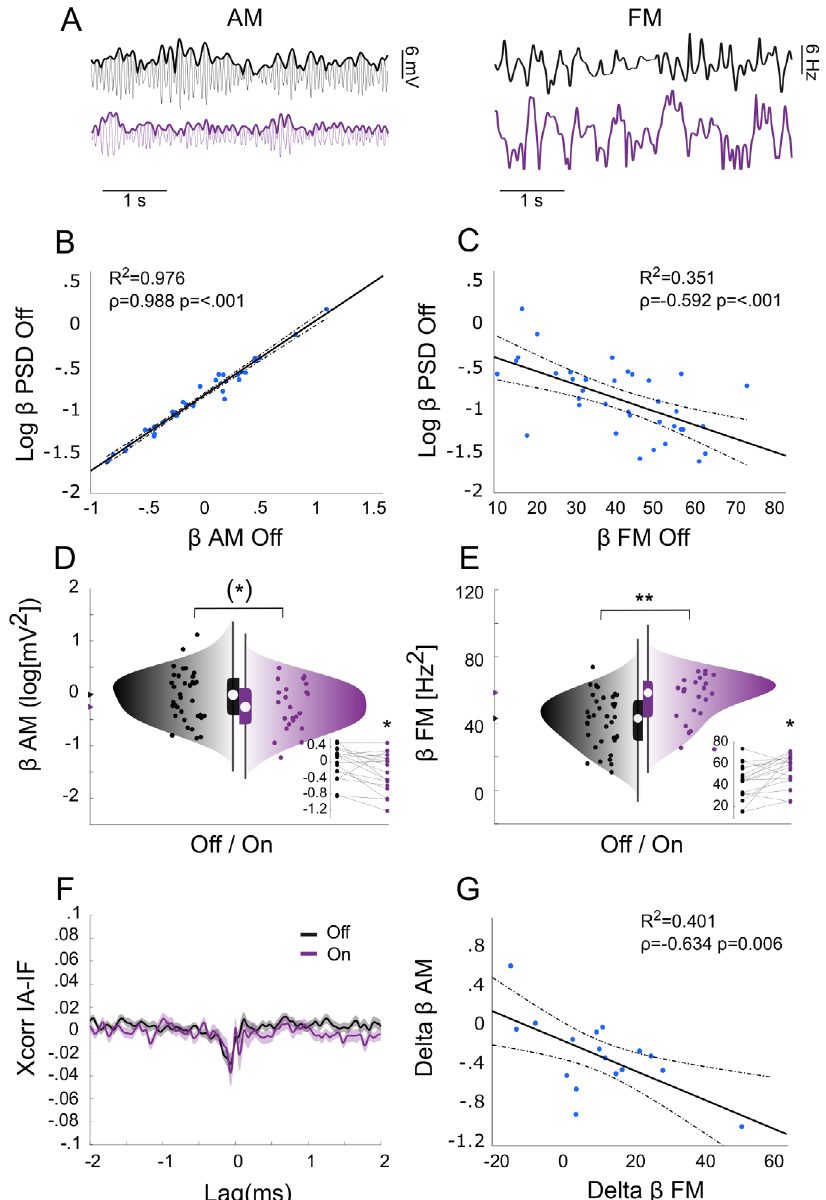
Fig. 2 Dopamine-dependent AM and FM of STN beta oscillations in PD patients. A Representative signals of instantaneous amplitude (left) and instantaneous frequency (right) before (black) and after (violet) levodopa. B , C Scatter plots of logarithmic power of the beta peak ( β PSD, y-axis) vs. ( B ) logarithmic variance of the instantaneous amplitude (AM, x-axis) or ( C ) variance of the instantaneous frequency (FM, x -axis) of the LFP fi ltered around the β peak across nuclei ( n = 36) before levodopa (OFF). Thick and dotted lines are the regression lines and corresponding 95% con fi dence limits, respectively. D , E Raincloud plots of ( D ) AM or ( E ) FM OFF levodopa (black, 36 nuclei) and ON levodopa (violet, 23 nuclei). Insets show AM or FM changes for the subset of subjects that were recorded in both the experimental conditions (17 nuclei). Data distribution ( ‘ cloud ’ ), jittered raw data ( ‘ rain ’ ) and box plots are reported. F Grand-average cross-correlation function calculated between instantaneous amplitude and instantaneous frequency OFF (black) and ON (violet) levodopa. Shaded areas represent the standard error of the mean (±s.e.m). G Scatter plots of dopamine-dependent changes AM (delta β AM) and FM (delta β FM). Thick and dotted lines are the regression lines and corresponding 95% con fi dence limits, respectively. * p < 0.1 ** p < 0.01. In the boxplots, the central white circle indicates the median and the box limits indicate the 25th and 75th percentiles. Whiskers at ±1.5 interquartile range. Levodopa decreased AM and increased FM, with a negative correlation between AM and FM both within and between dopaminergic negative peak both before (OFF) and after (ON) levodopa (Fig. 2F). Fig. 2D), and a moderate-to-strong evidence for an increase of FM Speci fi cally, the FM dynamics followed the AM dynamics, on after levodopa (All BF = 13.5, p = 0.003; Pre-Post BF = 3.7, average, by about 60 ms, which corresponds to approximately one p = 0.016; Fig. 2E). Beta power explained 89.7% of the variability cycle of the beta oscillation. The overall levodopa-dependent of beta AM changes, but only 30.6% of the variability of beta FM changes (ON – OFF) of AM and FM also displayed moderate changes across dopaminergic states (data not shown). evidence of negative correlation ( r = − 0.634, BF = 9.3, p = 0.006; Importantly, the cross-correlation function between instanta- Fig. 2G). The negative AM-FM correlations remained stable (or even neous amplitude and instantaneous frequency displayed a clear